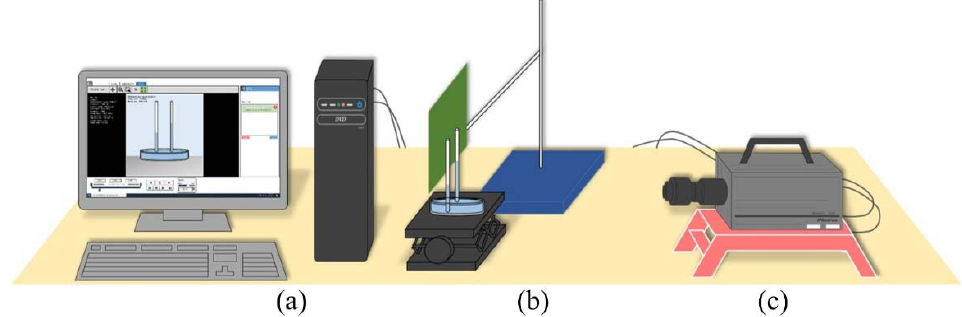
Figure 1. Schematic of the experimental setup. ( a ) PC and monitor, ( b ) capillary tube and liquid, and ( c ) high-speed camera and lens.